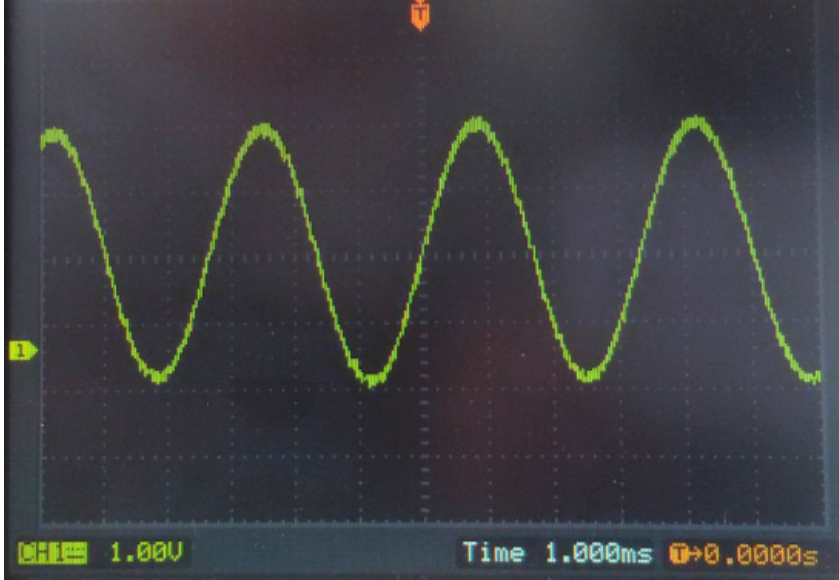
Figure 14. Transient output waveform of the integrated Hall sensor for a 1 kHz 170 mT sinusoidal magnetic flux